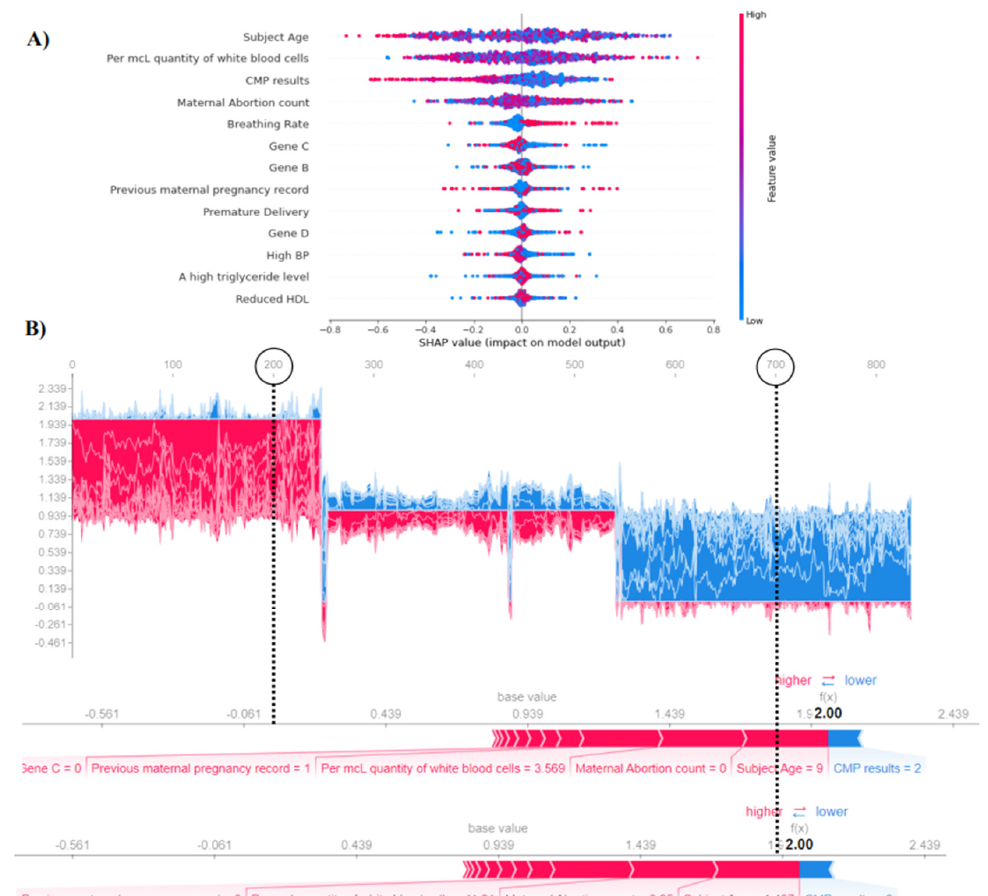
Figure 5. SHAP analysis over the KNNs classifier utilizing GA and BA optimizers. ( A ) Shows the most informative metabolic indicators found via KNNs. Blue dots show negative impact, whereas red dots show positive impact. ( B ) Shows SHAP global and local force plots at data observations of 200 and 700.